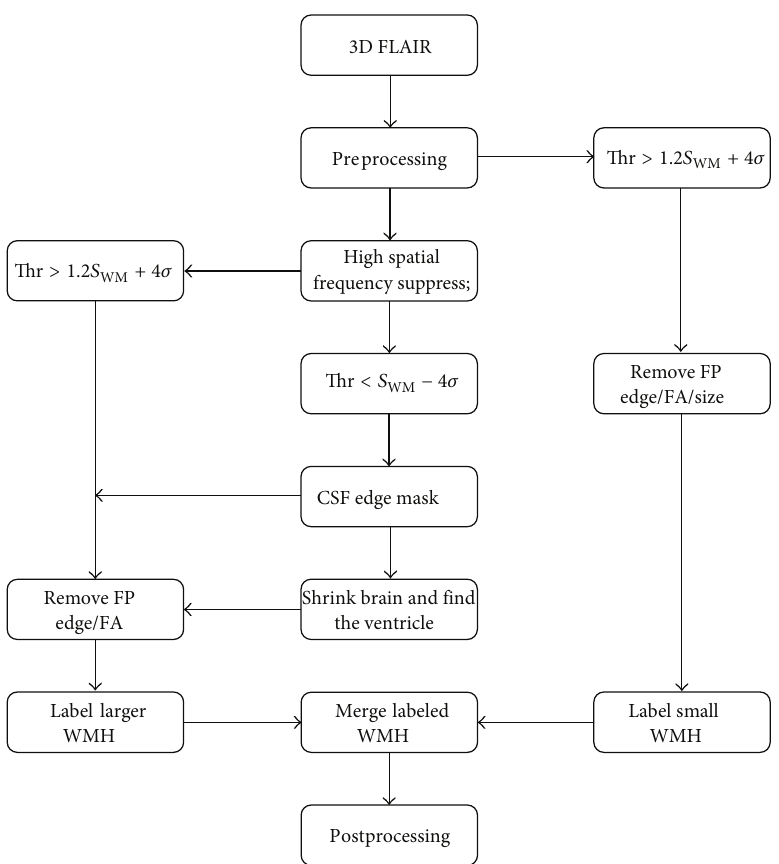
Figure 1: Overall work flow of the automatic quantification of WMH using 3D FLAIR